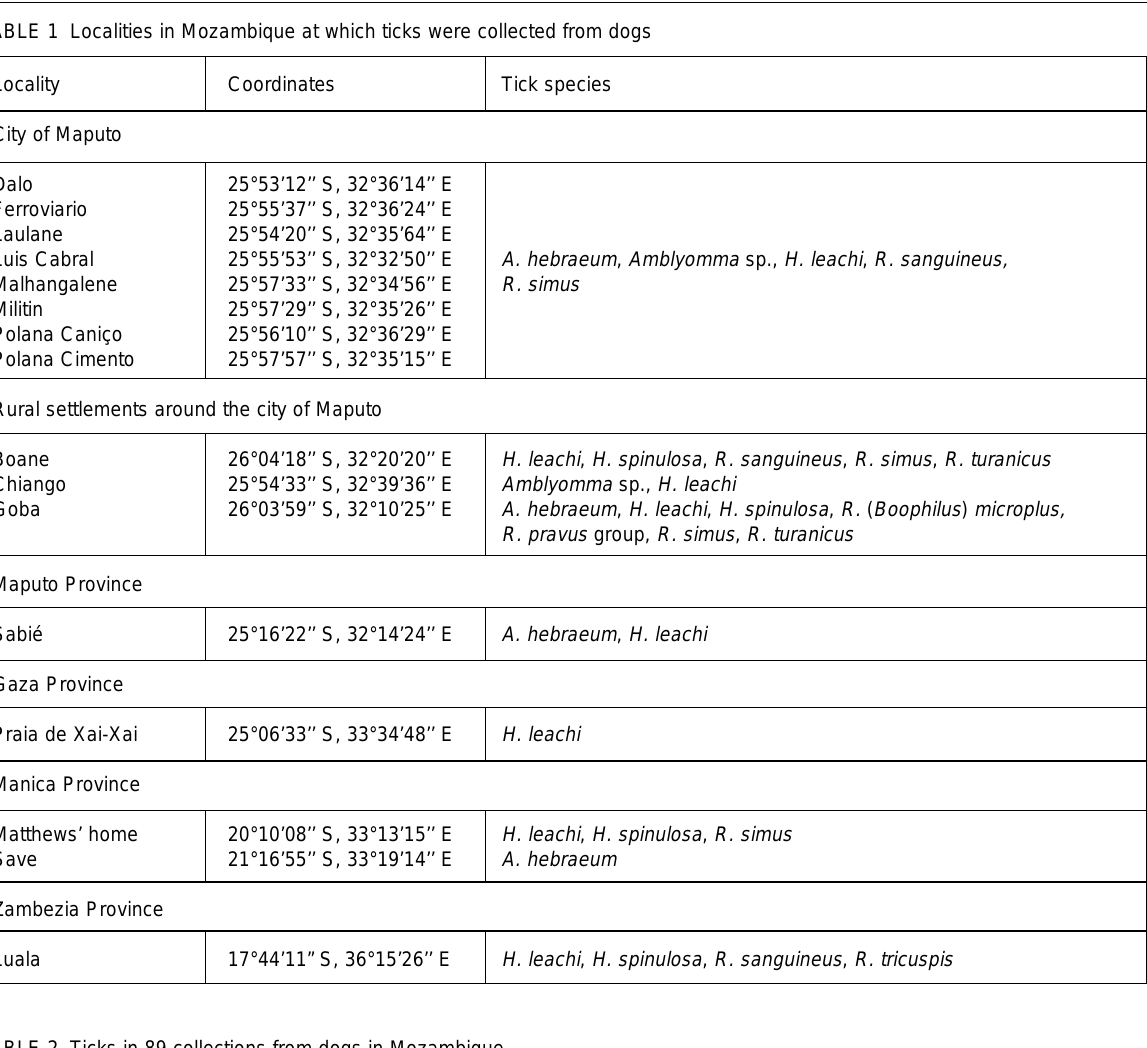
TABLE 2 Ticks in 89 collections from dogs in Mozambique Total number of ticks collected